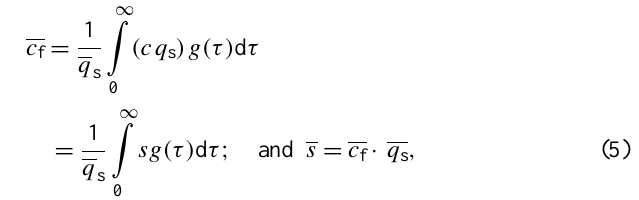
Fig. 3. Examples of different pathways of water flow and solute transport emerging from an arbitrary recharge location in a catch- ment. A statistical ensemble of pathways is obtained when consid- ering all recharge locations over the entire area of a catchment. The thick dashed lines indicate main average pathways and the thin dashed lines indicate examples of individual pathway variations (in space) and fluctuations (in time) around each mean. Depending on boundary conditions and catchment-internal structure (includ- ing prevailing average groundwater level and its fluctuations), wa- ter flow and solute flux will be partitioned differently between the two main (thick, dashed) mean pathways. Modified after Cvetkovic et al.